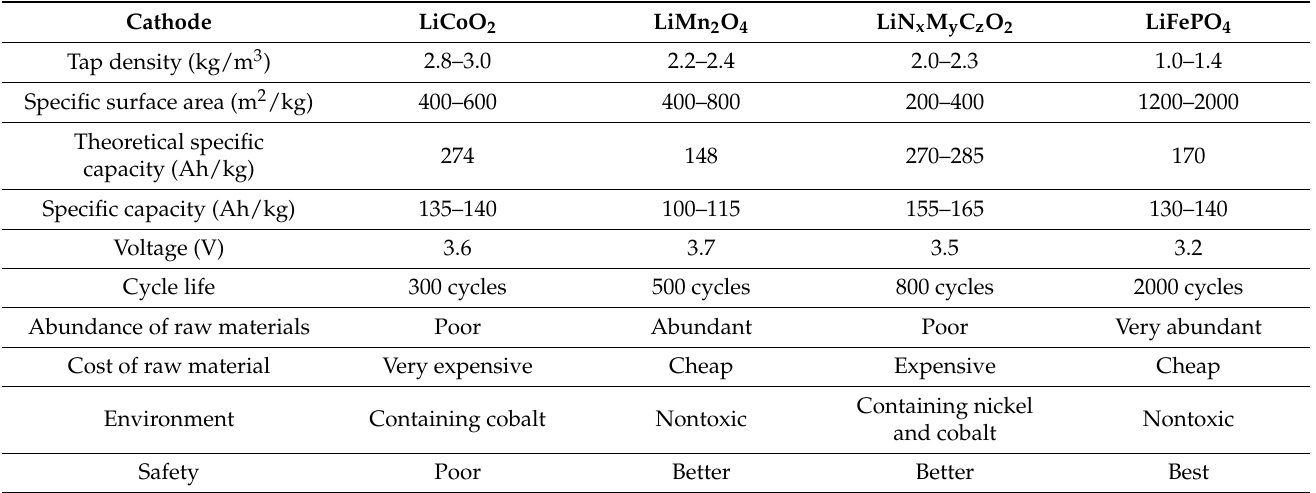
Table 1. Comparison among cathode materials